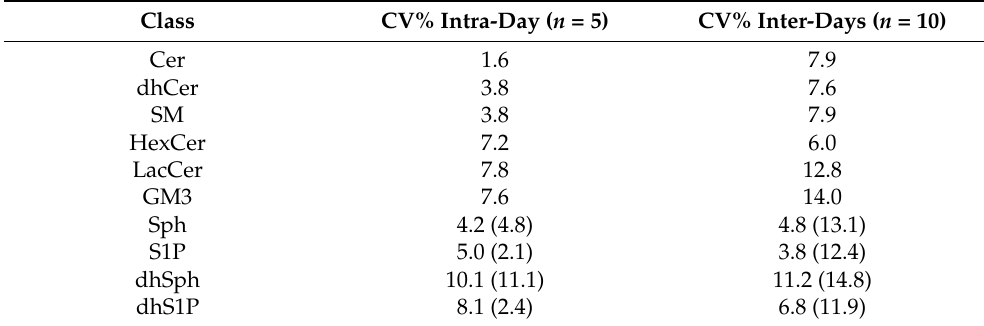
Table 1. Intra- ( n = 5 independent extraction replicates) and inter-days ( n = 10 independent extraction replicates) precision for the analysis of the whole panel of plasma sphingolipids on a plasma pool from healthy volunteers ( n = 20). The analyses of the sphingolipids and sphingoid bases were performed as described in Sections 3.3.1 and 3.3.2 (long chromatography), respectively.